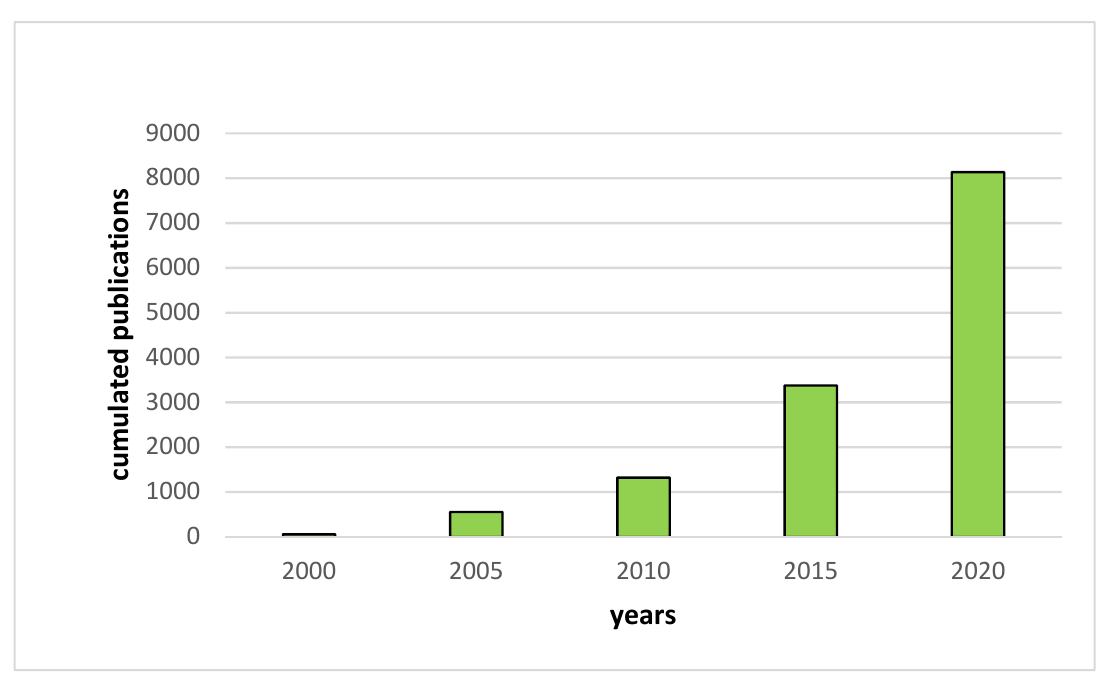
Figure 1. Evolution of the number of publications per year based on Web of Science results for “all solid-state battery”.